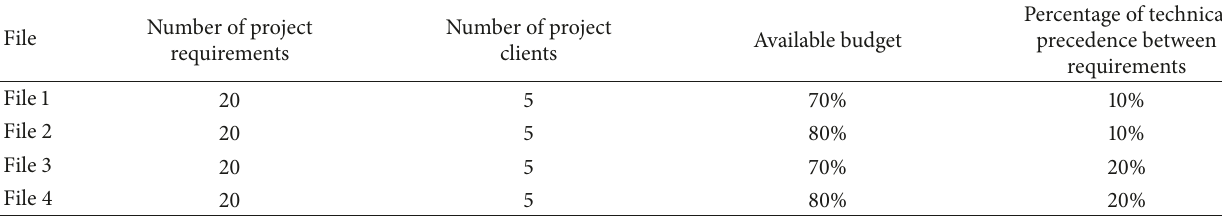
Table 1: Settings adopted in this work.